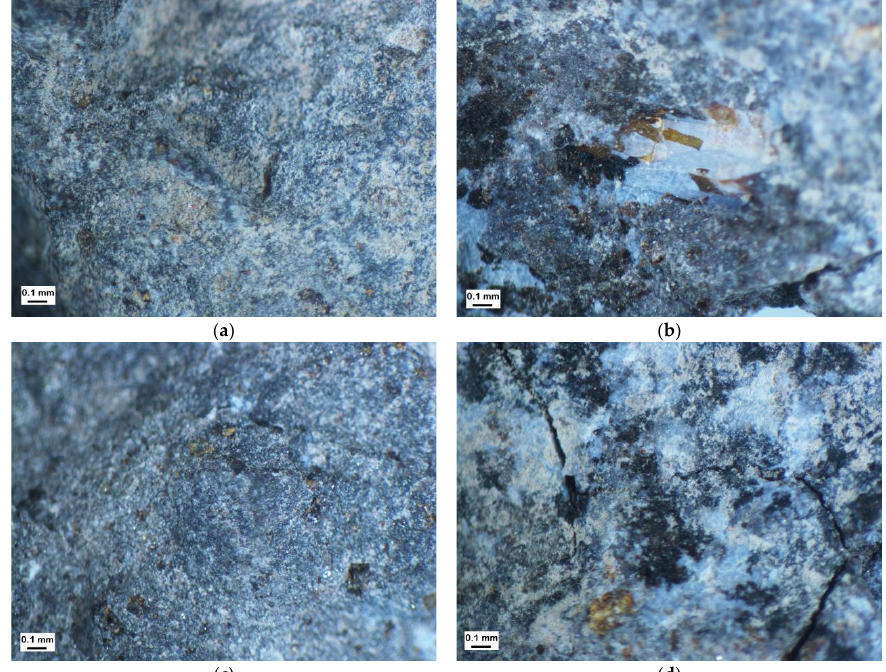
Figure A3. Characteristics of cracks in samples after crushing in cone crusher (feed — original sam- ple): ( a ) Basalt aggregate 1, non-flaky grains, +8 mm; ( b ) Basalt aggregate 1, non-flaky grains, +16 mm; ( c ) Basalt aggregate 1, flaky grains, +8 mm; ( d ) Basalt aggregate 1, flaky grains, +16 mm.